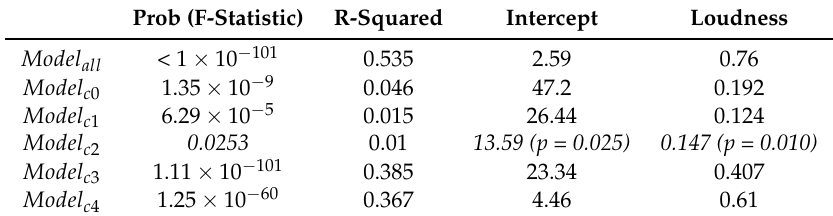
Table 3. Model Parameters for each of the five clusters, compared to a model learned over all data without using clustering. All parameters are statistically significant with p < 0.001 except otherwise specified.